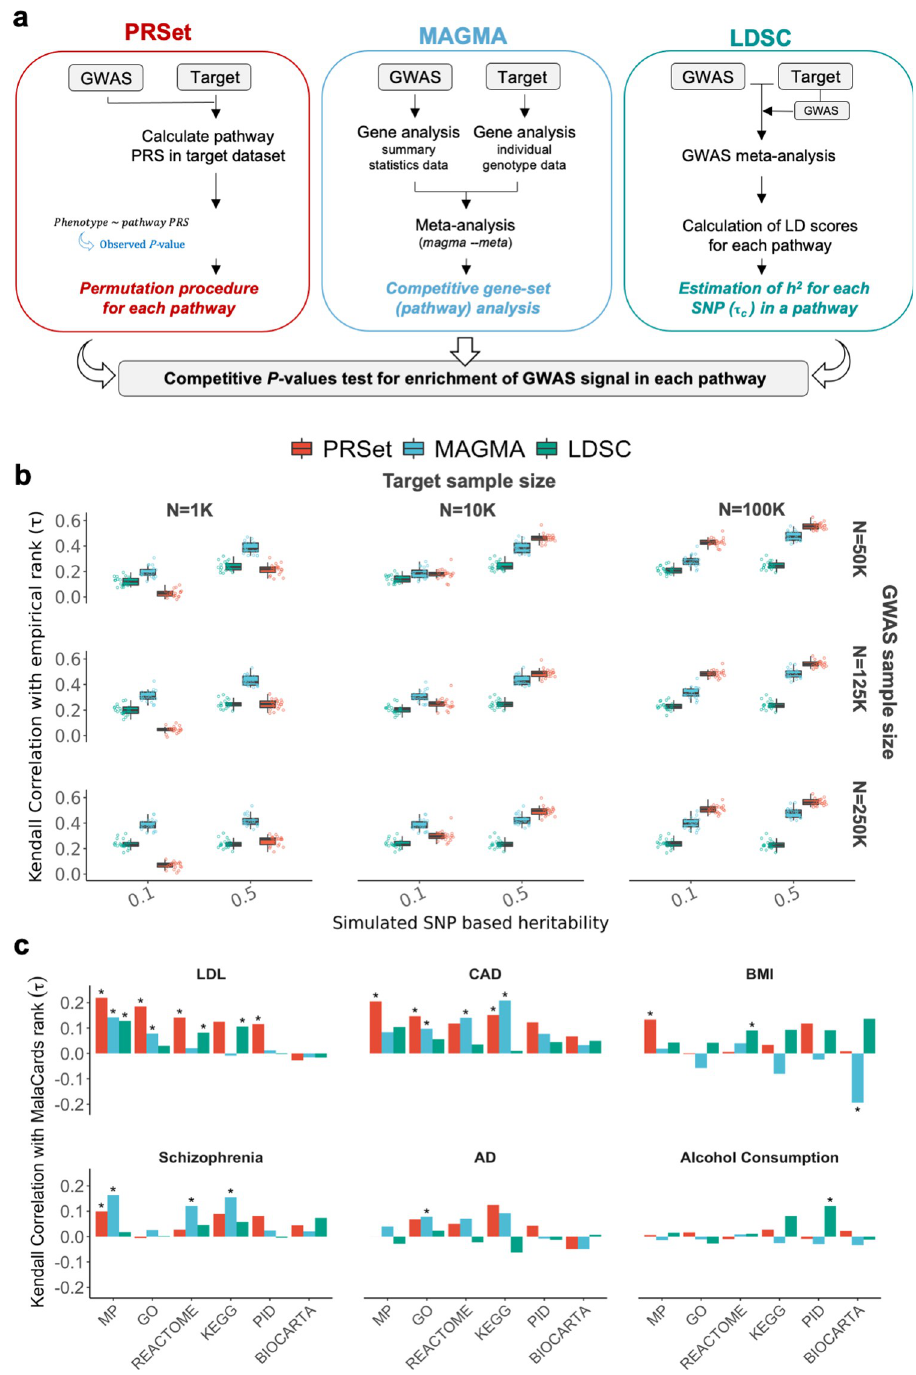
Fig 2. Evaluating pathway enrichment using canonical pathways. A, Schematic overview of PRSet, MAGMA and LDSC for assessing pathway enrichment . B, Pathway enrichment results for simulations with 50 random causal pathways. Performance is defined as the Kendall correlation between the pathway ranks based on competitive P- values of enrichment computed by each software and the empirical pathway ranks based on the true (simulated) effects across the pathways. Boxplots illustrate the values of Kendall rank correlation coefficients ( τ ) for PRSet, MAGMA and LDSC for each combination of heritability (h 2 = 0.1, 0.5), base sample size used in GWAS n = (50 k , 125 k , 250 k ), and target sample size n = (1K, 10K, 100K). C, Pathway enrichment results using real data for six diseases. Kendall correlation coefficients ( τ ) between pathway ranks based on competitive P- values of enrichment computed by each software and pathway ranks based on MalaCards disease relevance scores. � Empirical P- value < 0.05. MP, Mouse Genome